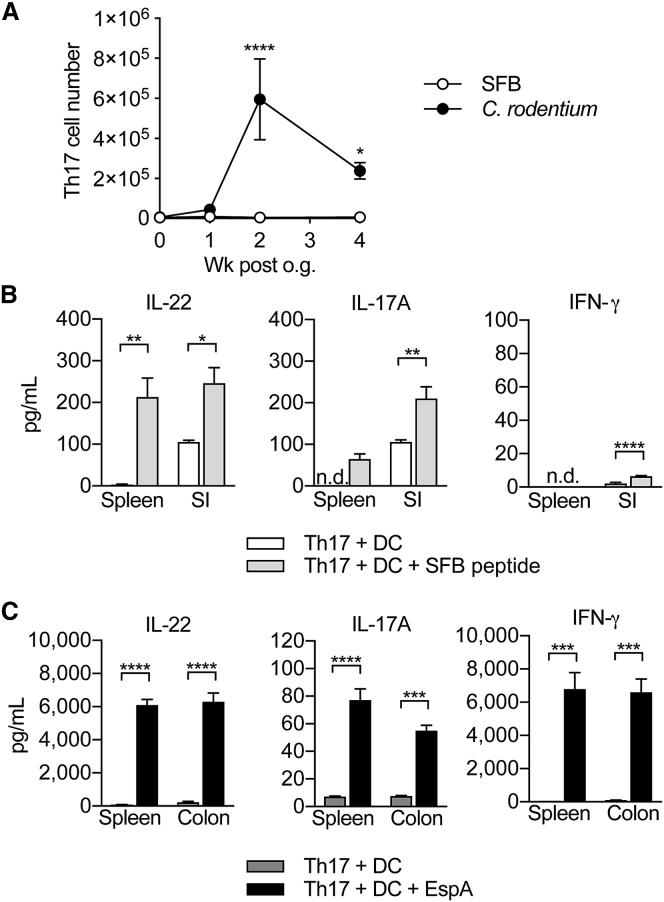
Peripheral Th17 Cells Retain Their Antigen-Specificity in Response to SFB and C. rodentiumShown in (A) are the absolute numbers of Th17 cells in the spleen of mice colonized with SFB or infected with C. rodentium at 0 (n = 11 and 5), 1 (n = 10 and 6), 2 (n = 12 and 6), and 4 (n = 6 and 8) weeks after gavage. Symbols show the mean ± SEM. Cytokine concentration in supernatants of FACS-purified Th17 cells from the spleen and SI of mice colonized with SFB (B) or from the spleen and colon of mice infected with C. rodentium (C), cultured with DCs and SFB peptide (B) or EspA (C). Bars show the mean + SEM of technical replicates (n = 3–4). Cells were FACS-purified from one sample per group, obtained by pooling 3–6 mice. Results are representative of three (B) and two (C) independent experiments. ∗p < 0.05, ∗∗p < 0.01, ∗∗∗p < 0.001, ∗∗∗∗p < 0.0001 by two-way (A) or one-way (B and C) ANOVA with Sidak’s (A) or Tukey’s (B and C) post-test. n.d., not detected. See also Figure S3.